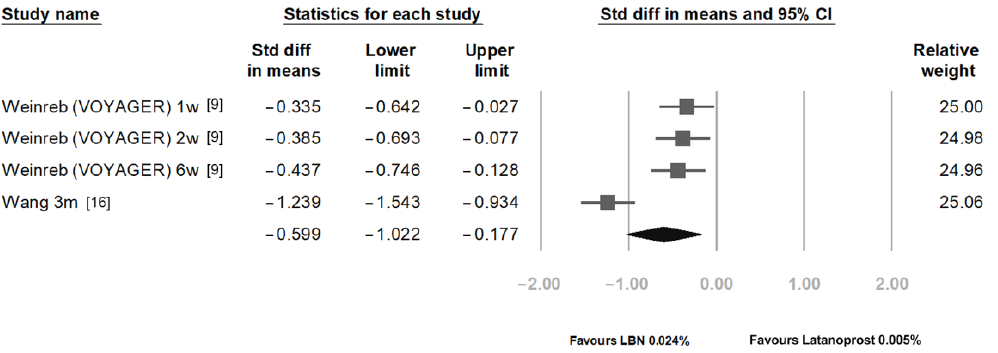
Figure 4. Comparison of IOP-lowering effects of latanoprostene bunod 0.024% and latanoprost 0.005%. Subsequently, we recorded the adverse events in each study to assess the safety of LBN 0.024%. The three most common ocular side effects were conjunctival hyperemia, eye irritation, and dry eye, as shown in Table 3. The percentage of patients who had at least one adverse effect ranged from 8.7% to 50.8%. However, no serious adverse effects threatening vital signs or permanently decreasing vision were reported. Table 3. Treatment-related ocular adverse effects in studies included in meta-analysis. Study